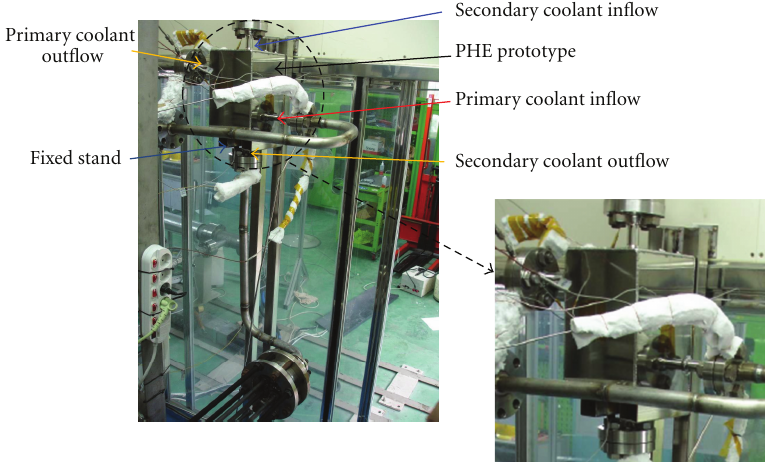
Figure 5: Setup of a PHE prototype in the gas loop.